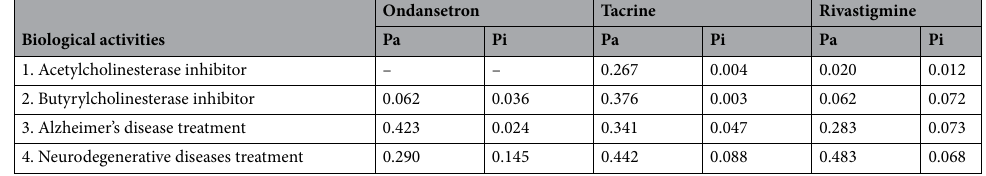
Table 3. PASS predictions of biological activities a for Ondansetron Tacrine and Rivastigmine. a Pa: Predicted probability of substance being active. Pi: Predicted probability of substance being inactive.